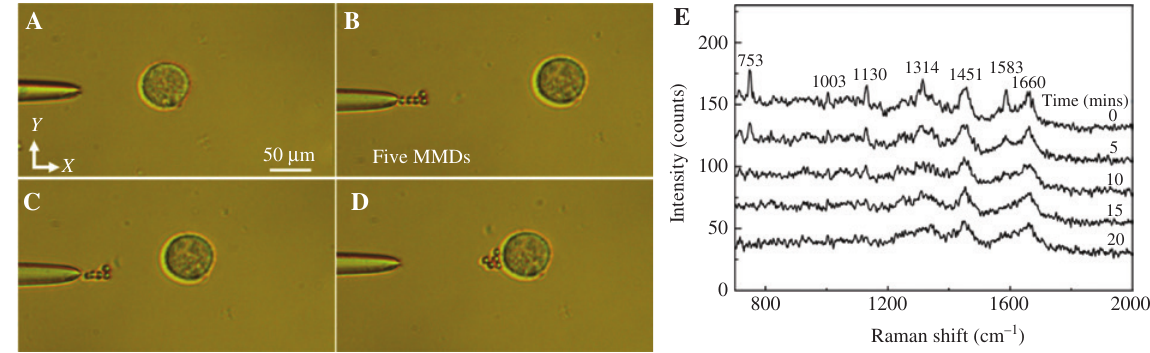
Figure 4: The optical microscope images of delivering five MMDs and the Raman spectrum of the targeted HeLa cell over time. (A) No MMDs exist within a range of 1000 μ m of the targeted HeLa cell and the TFP was prepared for the following trapping and delivering experiment. (B–D) The five trapped MMDs were delivered to the position with distances of 130, 65 and 0 μ m from the targeted cell, respectively. (E) The Raman spectrum of the targeted cell with the different therapeutic